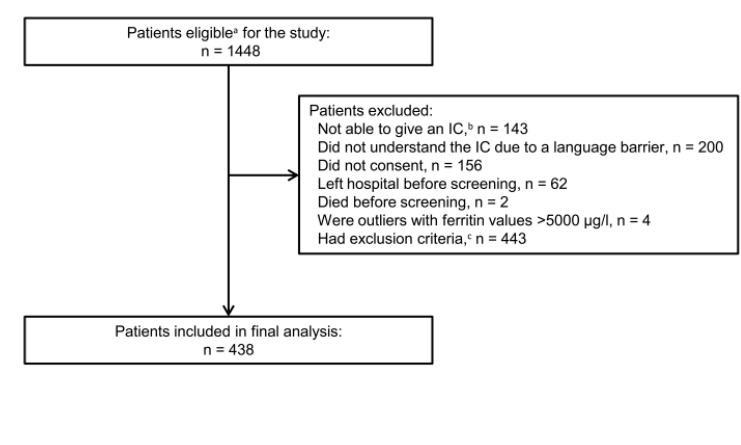
Figure 1: Selection of patients for final analysis. IC = informed